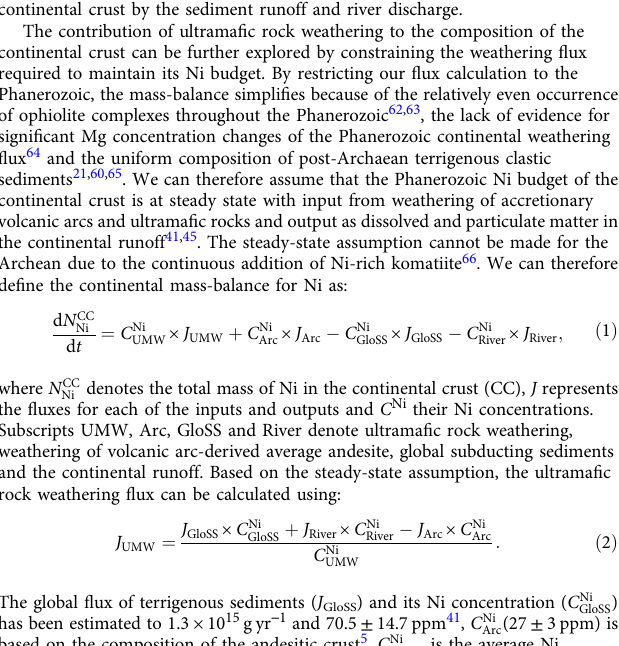
Supplementary Table 1. The reproducibility of δ 26 Mg analyses was assessed by replicate analyses of Mg reference standards reported in Supplementary Table 1 and was typically better than 0.08 ‰ . Moreover, dolomite standard JDo-1 and Mg standard CAM-1 were identically processed resulting in compositions similar to those reported elsewhere 72 – 74